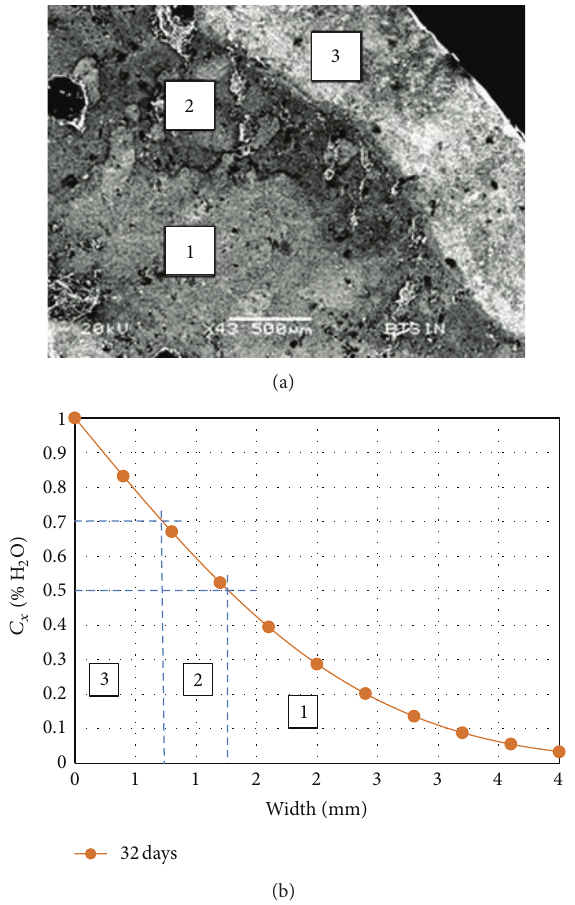
Figure 5: (a) SEM image of the surface of the polyurethane adhesive MCB specimens after fracture following a 32-day immersion period in seawater. (b) Different zones as a function of water concentration.